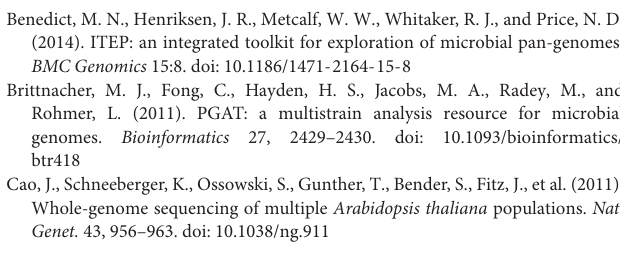
TABLE S1 | The function comparation of online pan-genome analysis